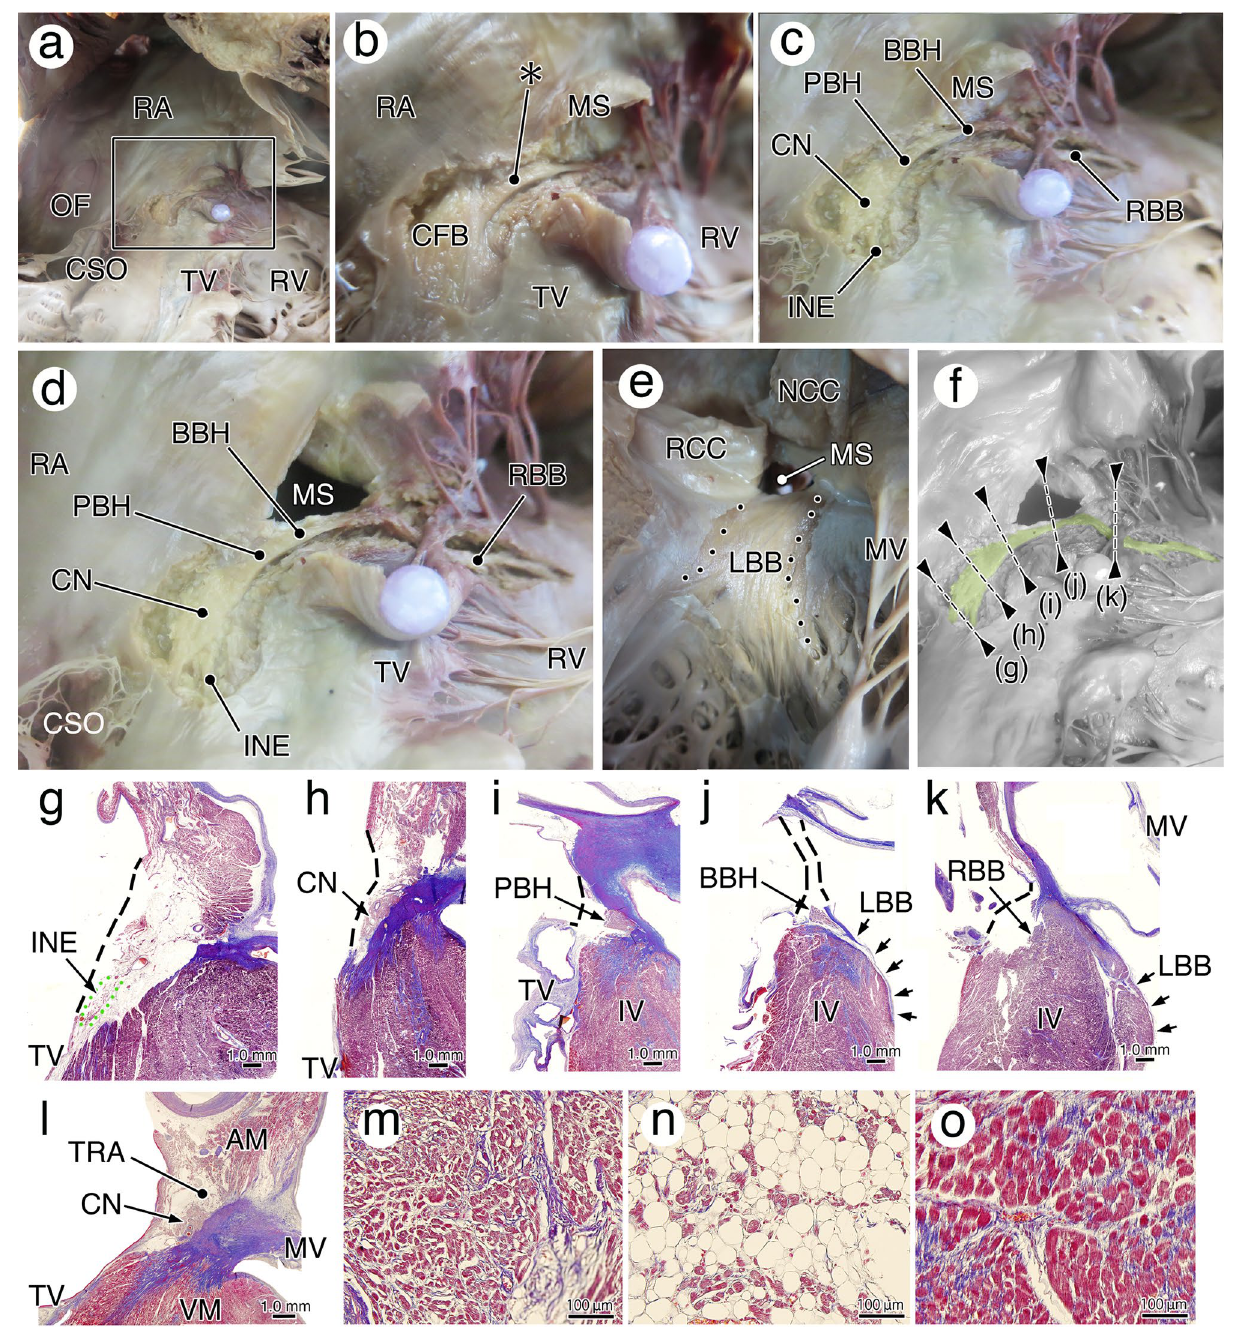
Figure 6. The anatomy and histology of the human atrioventricular conduction system. ( a – e ) The dissection steps based on the histologic criteria for identification of the atrioventricular conduction axis (AVCA). The lower ( a ) and higher ( b ) magnification photographs showing the starting dissection point. The expected bundle of His (*, BH) with different muscular arrangement of the ventricle is first detected. ( c ) Relying on continuation with the BH, the compact node (CN) and right bundle branch (RBB) are traced. After cutting off the membranous septum (MS) ( d ), the left bundle branch (LBB) is exposed at the left chamber view ( e ). The exposed AVCA, colored in green ( f ) , clearly identified the conduction tissues ( g – k ). Black dots show the dissected area. ( l ) The section of heart through the CN shows the different cytological characteristics of the nodal cells ( m ), transitional cells ( n ), and atrial myocytes ( o ). AM atrial muscle, BBH branching bundle of His, CFB central fibrous body, CSO coronary sinus orifice, INE inferior nodal extension, IV interventricular